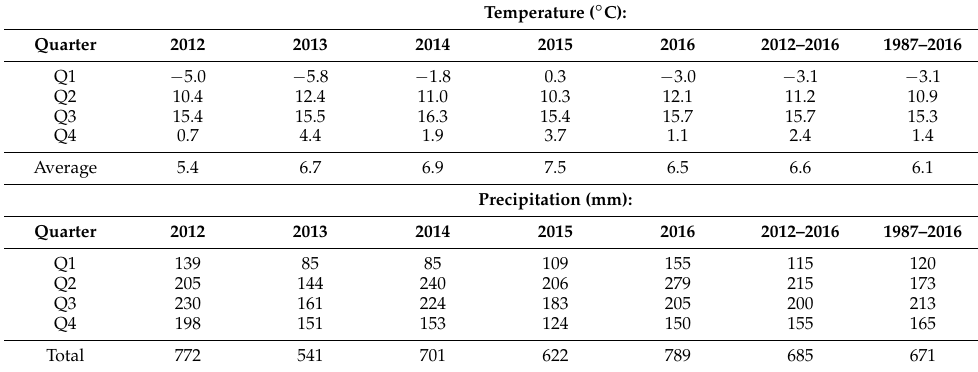
Table 1. The average air temperature and sum of precipitation, during the years of study and compared with long-term (30-year)